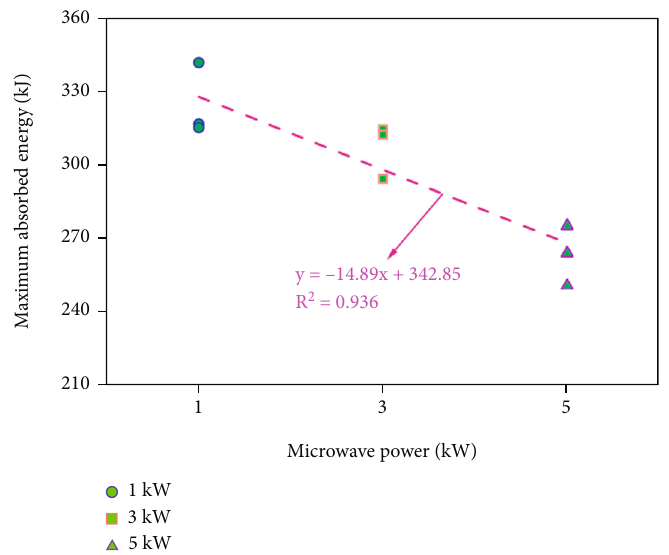
Figure 6: The maximum absorbed microwave energy versus microwave power